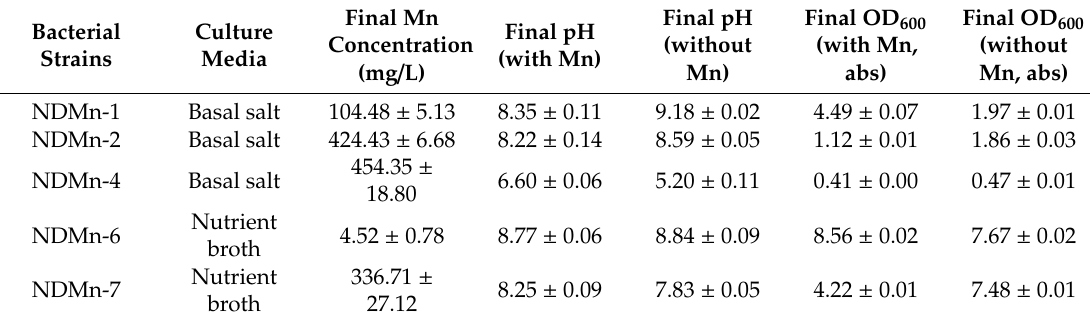
Figure 1. Manganese removal by strains ( a ) NDMn-1, ( b ) NDMn-2, ( c ) NDMn-4, ( d ) NDMn-6, and ( e ) NDMn-7, together with the biotic control of each strain. Table 2. Mn removal by five isolated